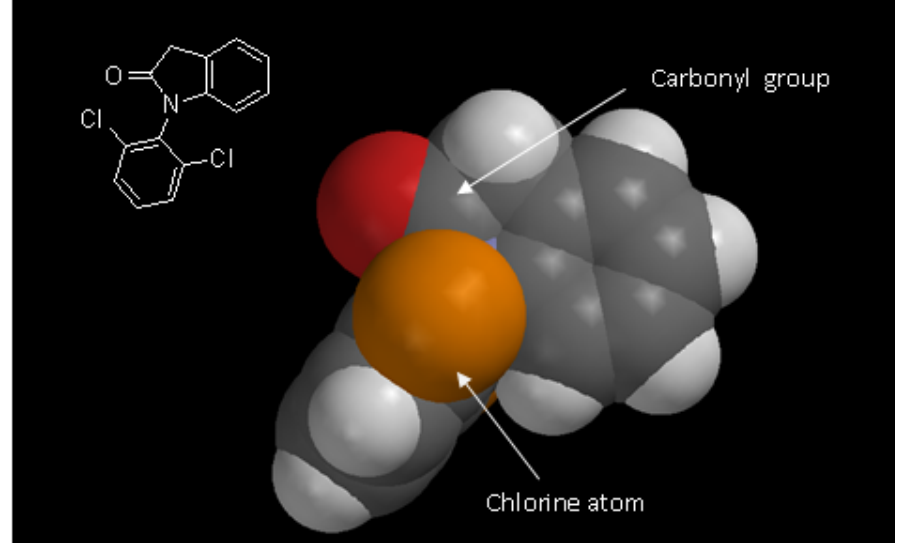
Figure 3. Space filling model showing the steric hindrance of carbonyl caused by chlorine atom to nucleophilic attack in hydrolysis reaction (gray: carbon; red: oxygen; white: hydrogen; orange: chlorine structure obtained by Spartan Pro PC 1.0.5 program – wavefunction,